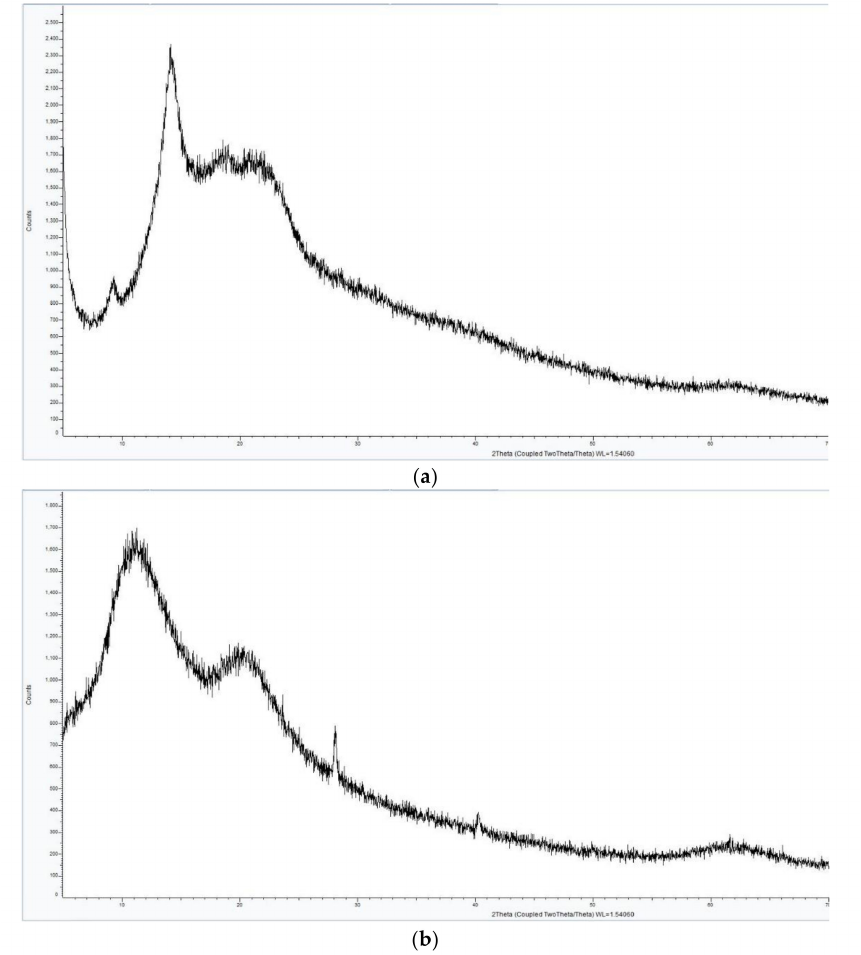
Figure 3. X-ray di ff raction (XRD) analysis of two complexes. From up to down: ( a ) AV-PVP-I 2 ; ( b ) AV-PVP-I 2